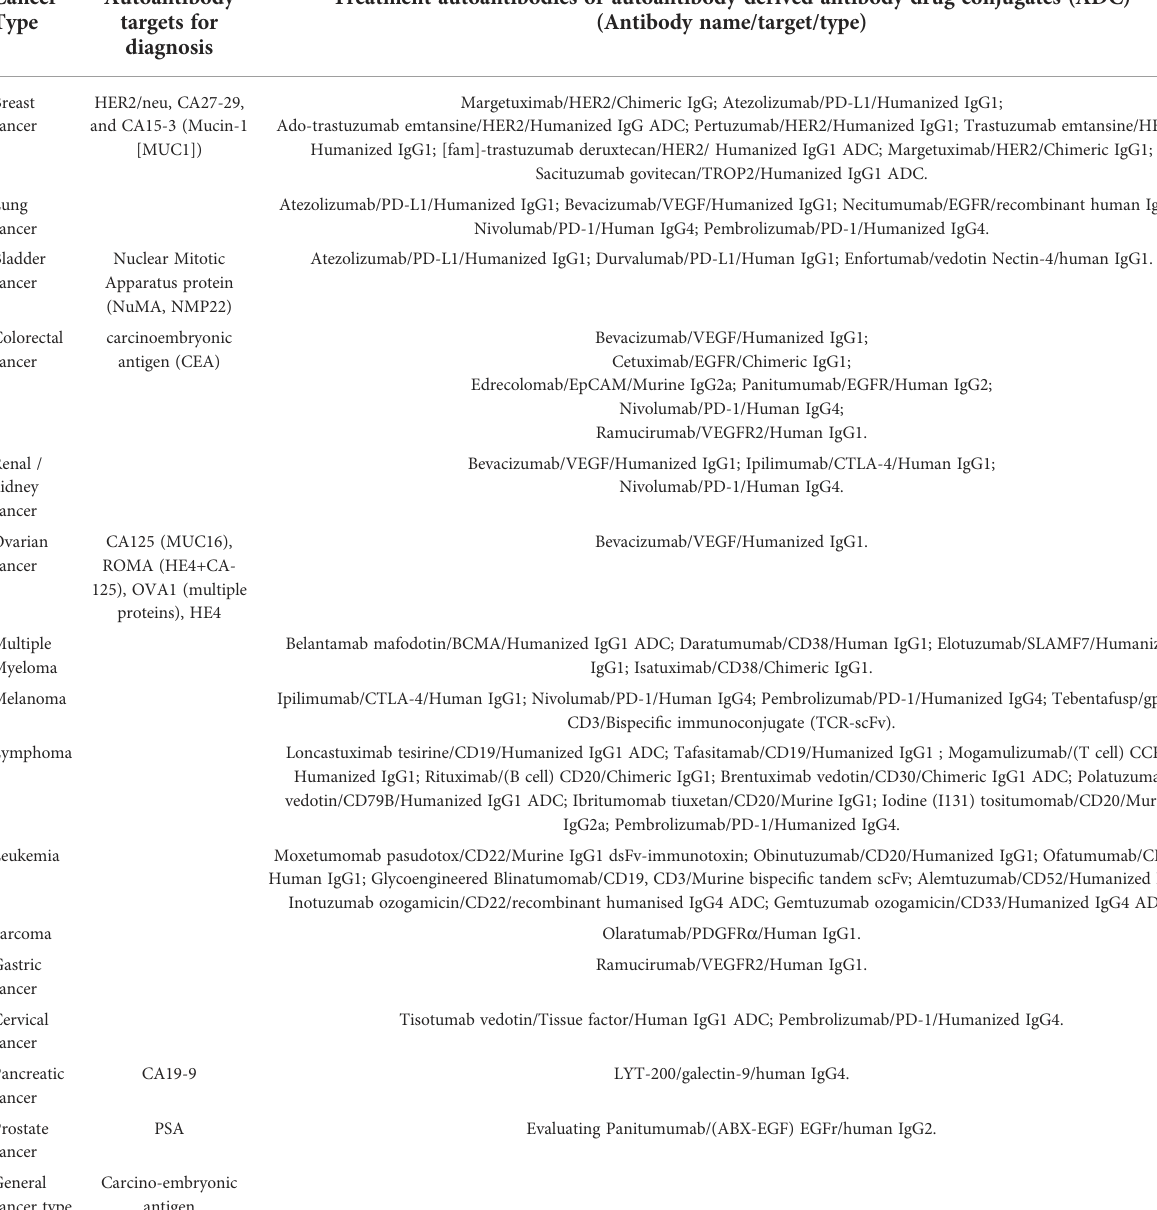
TABLE 2 Summary of EU and/or US FDA-approved autoantibody targets for cancer diagnosis and of autoantibodies/autoantibody-derived antibodies for cancer treatment .